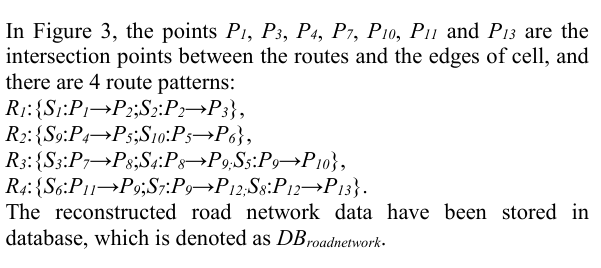
Figure 3. The cell route pattern